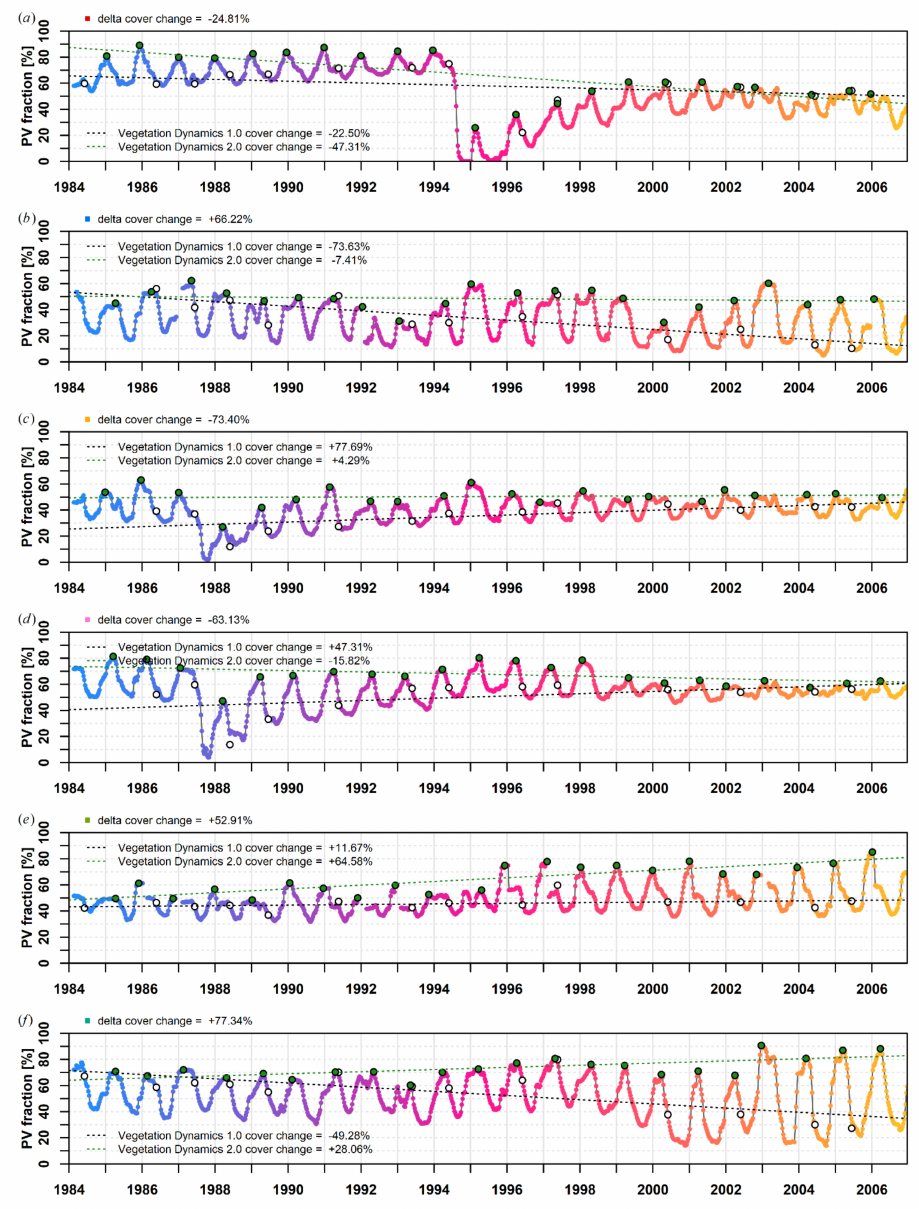
Figure 7. Representative time series for the different delta cover change types in Figure 6. Color coding as in Figure 3. Green circles represent the value of peak of season (VPS) metric (Vegetation Dynamics 2.0); white circles are the statically selected images from Vegetation Dynamics 1.0. Regres- sion lines and cover change for both methods are shown. Subplots ( a – f ) are representative pixels that are referred to in the text below. The point locations are shown in Figure